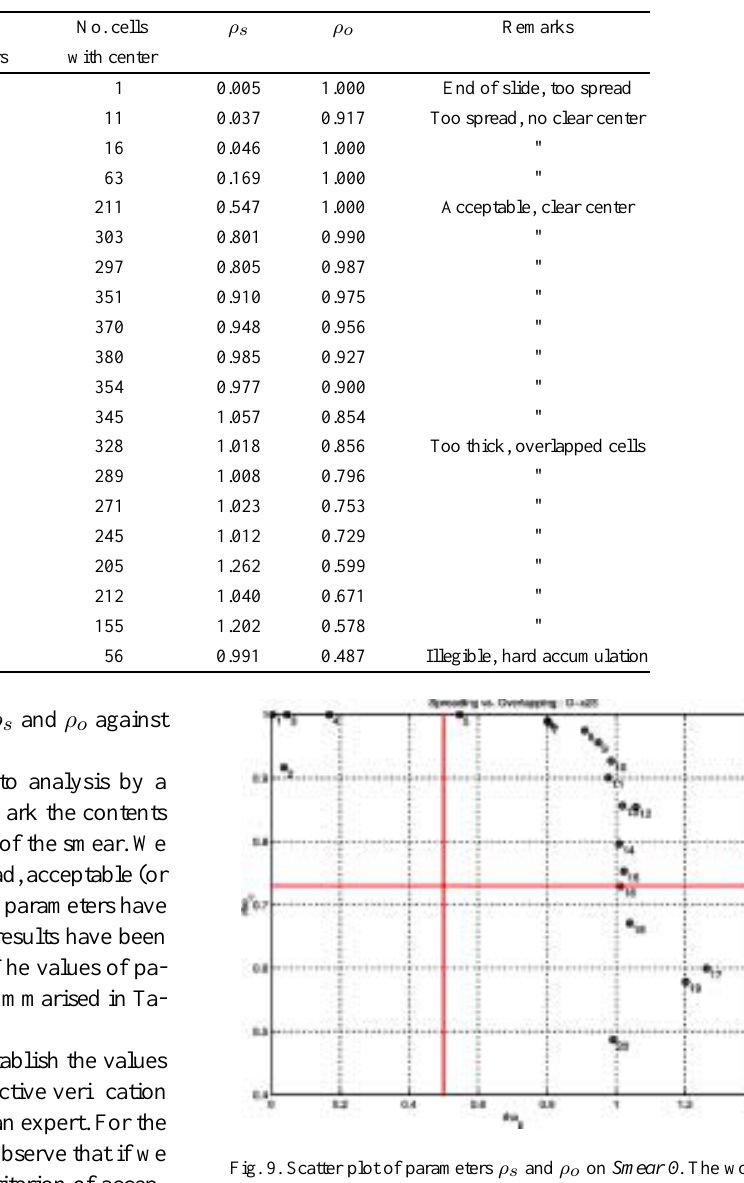
Fig. 9. Scatter plot of parameters ρ s and ρ o on Smear 0 . The work- ing zone belongs with the upper-right quadrant. This figure can be viewed on